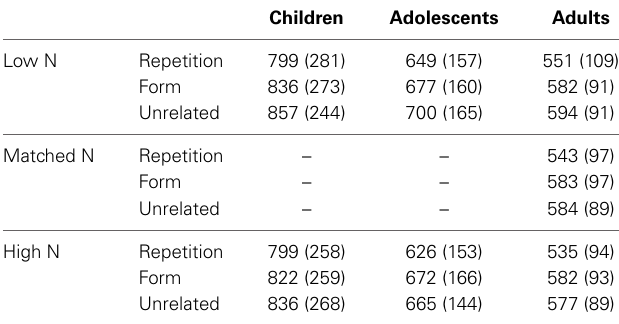
Table 4 | Reaction time on lexical decision